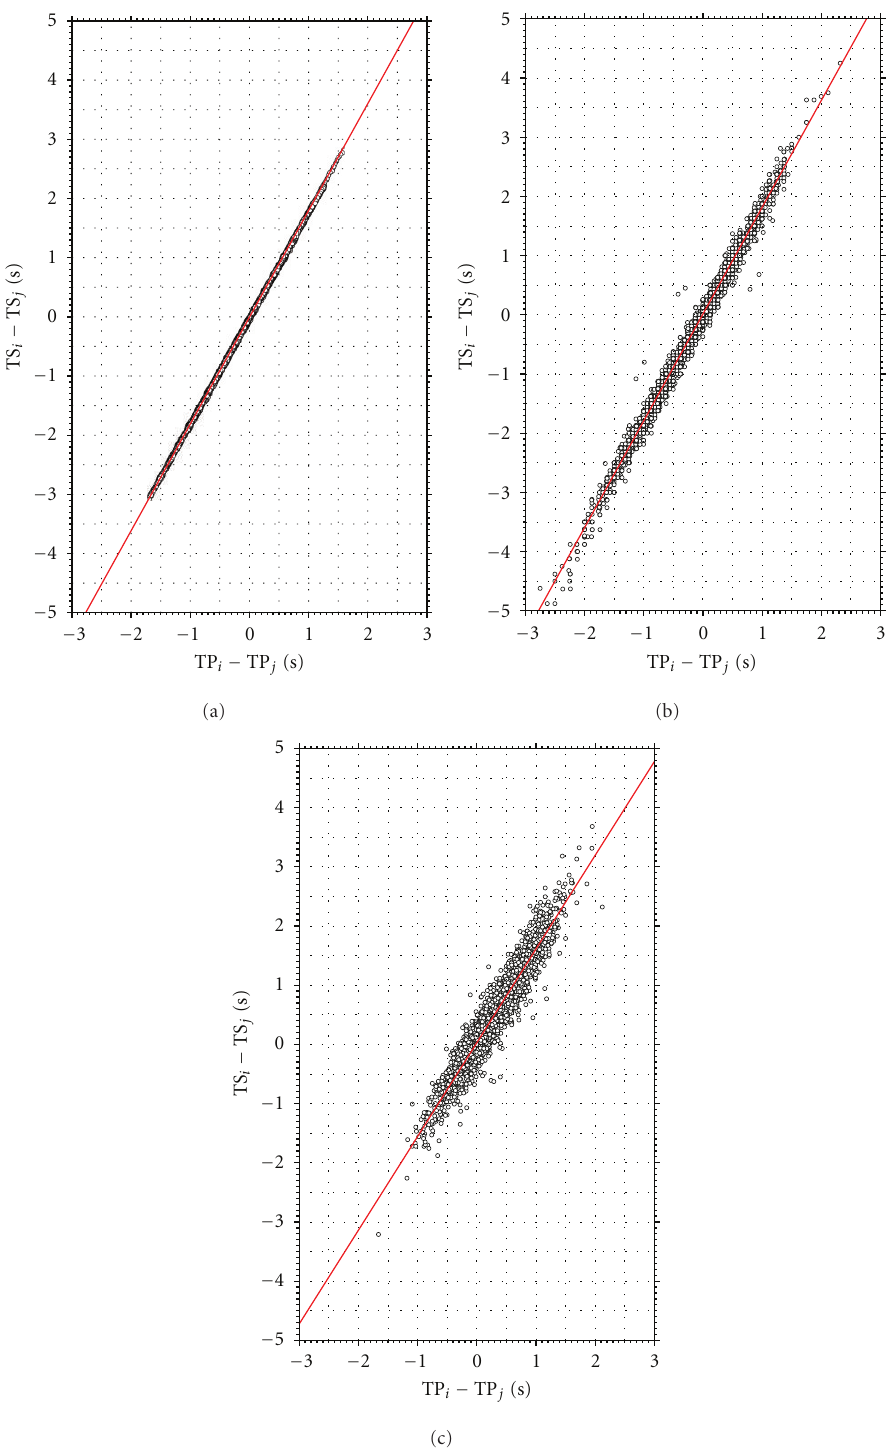
Figure 9: Modified Wadati diagrams of the (a) original synthetic dataset, (b) synthetic data with added noise, and (c) Wisconsin dataset,